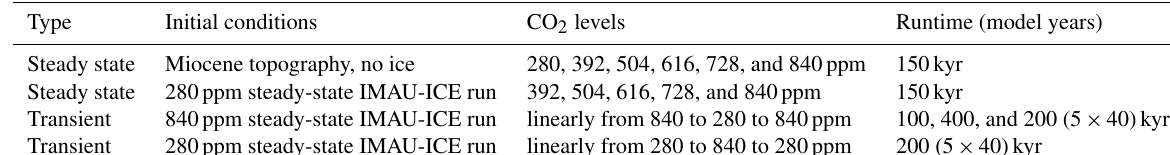
Table 2. Description of the 15 simulations spanning each experiment.